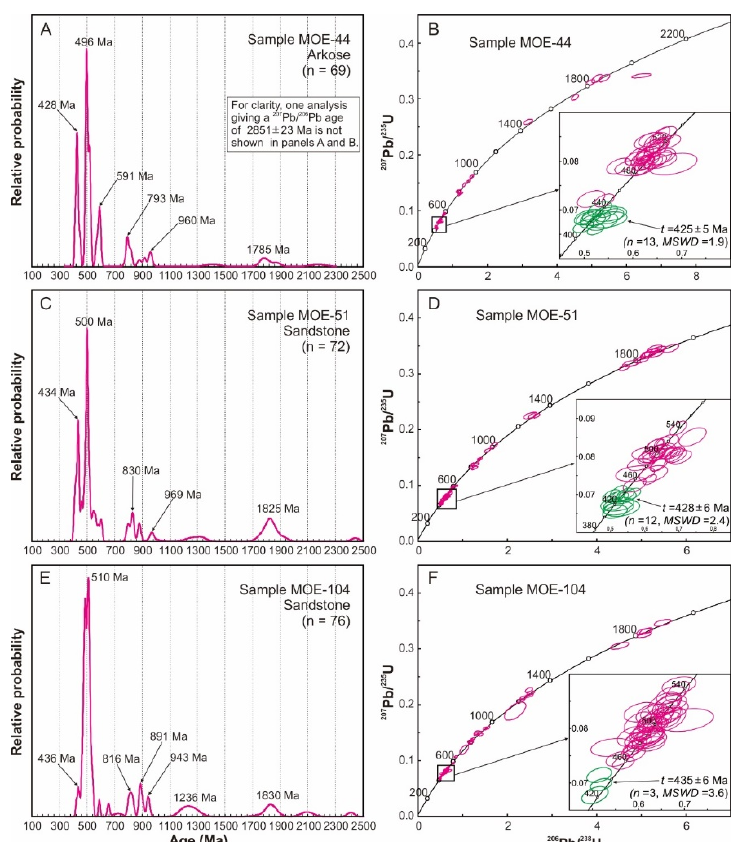
Figure 10. Detrital zircon age-relative probability curves ( left ) and concordia diagrams ( right ) for samples MOE-44 ( A , B ), MOE-51 ( C , D ), and MOE-104 ( E , F ) from Devonian sedimentary sequence on the Ereendavaa terrane in NE Mongolia.